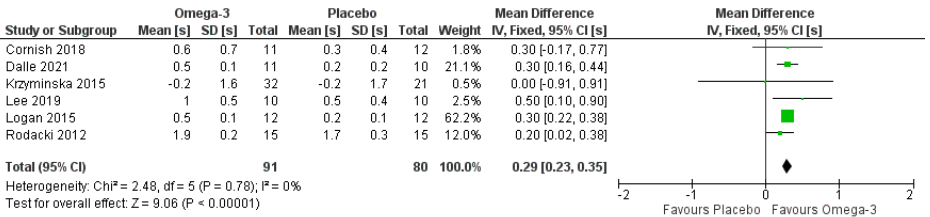
Figure 4. Pooled analysis of the impact of omega-3 supplementation with and without resistance training on upper body strength [27–31,33,34,36,37,39–41]. Figure 5. Pooled analysis of the impact of omega-3 supplementation on timed-up-and-go test. Note